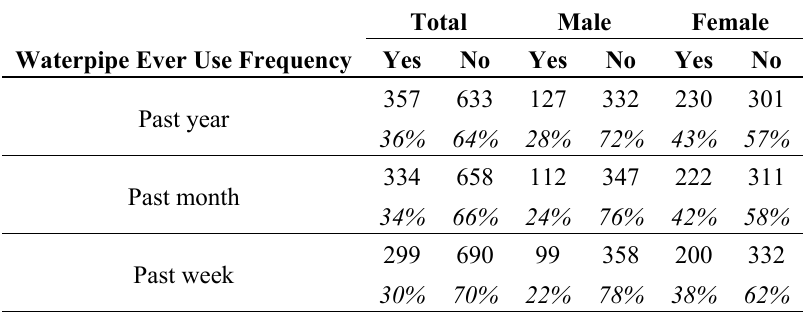
Table 2. Distribution of study participants by waterpipe smoking and gender (n = 993).